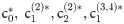
Remodeling curves for (a) femoral and (b) tibial arteries in the absence (blue) and presence (red) of MS throughout of a hypothetical life span (70 years) of an individual person. a) In femoral arteries the reduction of the Normalized Lumen Area (NLA) in patients with atherosclerosis without MS is approximately 15% and about 30% in patients with atherosclerosis and MS. b) In tibial arteries the reduction of the NLA in patients with atherosclerosis and without MS is approximately 55% and about 75% in patients with atherosclerosis and MS. Intima and media parameters and associated stiffening rates are given in Tables B, D, E, and F in S1 Appendix. Non-MS media stiffening rates are 1/10 of MS stiffening rates. Dashed lines represent lower and upper bounds, estimated by taking the largest and smallest (non-zero) values of c0*,c1(2)*,c2(2)*,c1(3,4)* and c2(3,4)* from reference [21].